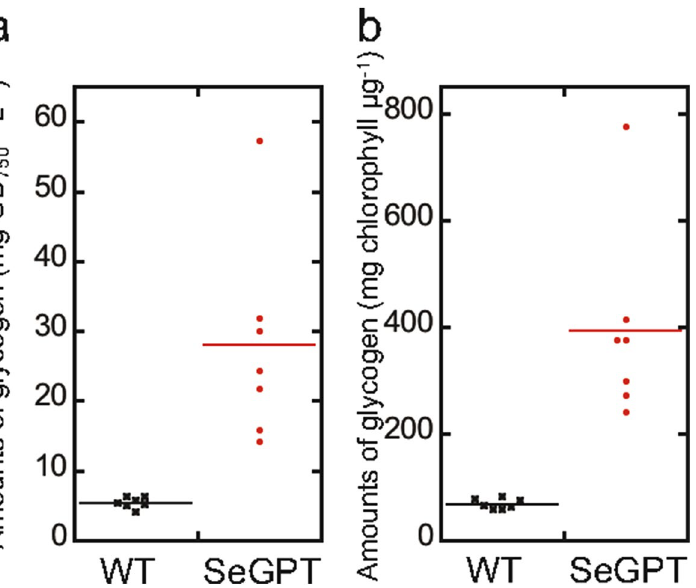
Figure 5. Measurements of intracellular glycogen content. WT and SeGPT cells grown under continuous light conditions were withdrawn at the indicated times and intracellular glycogen was quantified. Data were normalized to OD 750 ( a ) or chlorophyll ( b